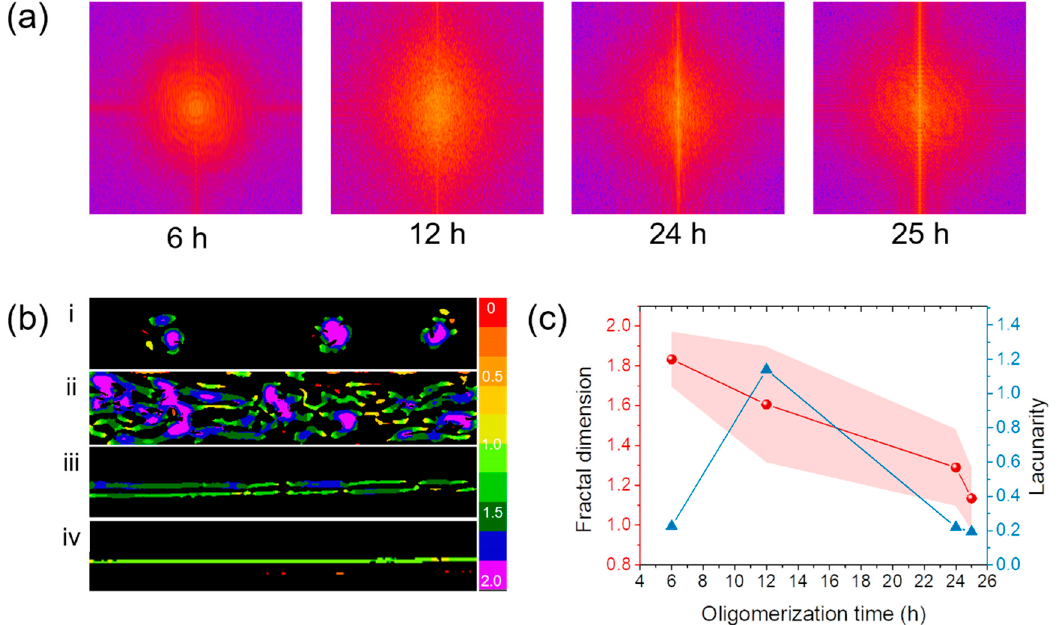
Figure 4. Spatial-confinement effects on shape change of nematic liquid crystal drop over oligomer- ization time. ( a ) Fast Fourier transform (FFT) images of spatially confined nematic liquid crystals at different oligomerization times. ( b ) Images of local connected fractal analysis at different oligomer- ization times: (i) 6 h, (ii) 12 h, (iii) 24 h, and (iv) 25 h. ( c ) Fractal dimension ( ● ) and lacunarity ( ▲ ) of spatially confined grown nematic liquid crystals over oligomerization time.